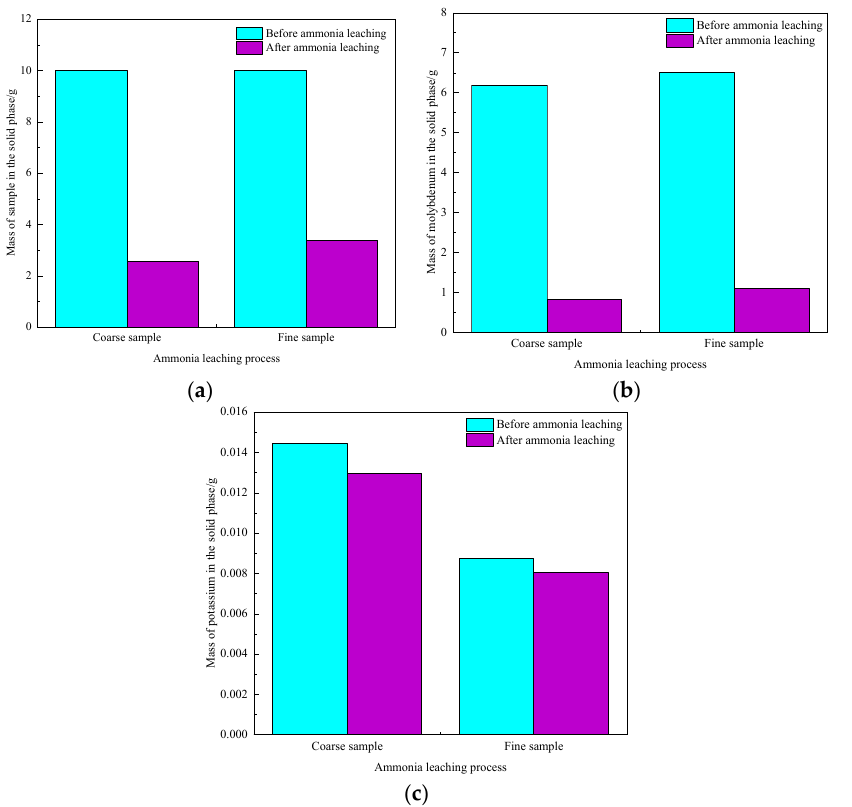
Figure 13. Mass change of elements in samples with different particle sizes during ammonia leaching. ( a ) Mass change of sample, ( b ) mass change of Mo, ( c ) mass change of K.